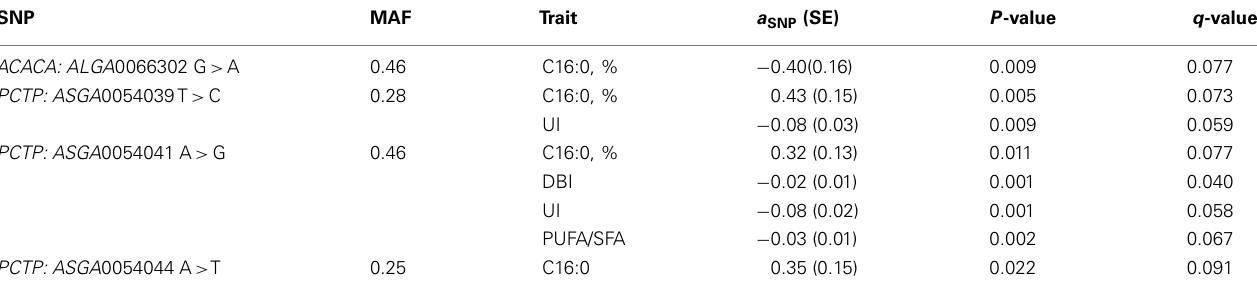
Table 3 |Association analyses: significant effects of SNPs within candidate genes in the QTL region. SNP MAF